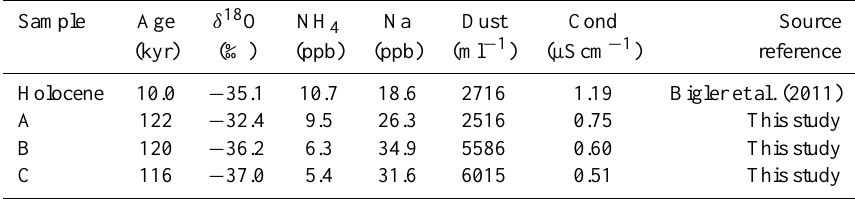
Table 2. Absolute concentration levels of the measured parameters compared to early Holocene values.